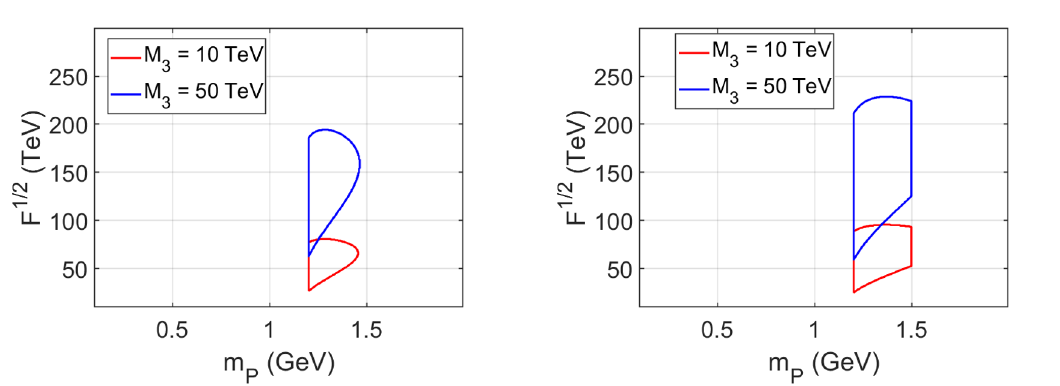
Figure 28 . Sensitivity regions of FASER-I to the model parameters, where pseudoscalar sgoldstinos are produced directly and then decay inside the detector volume into mesons. When only charged mesons are used as a signature, the regions are presented on left panel. The right panel shows the region, when both charged and neutral mesons are adopted as sgoldstino signatures. A Q = 100 GeV. √ √ In the regions where F < M 3 we set M 3 = F .